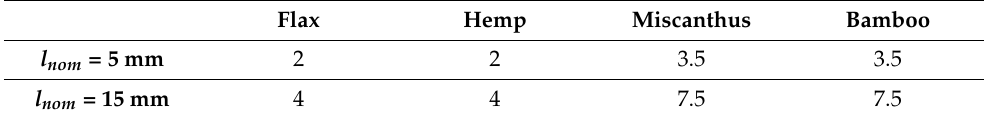
Table 1. Actual fiber lengths (average) as function of the fiber material and nominal length.